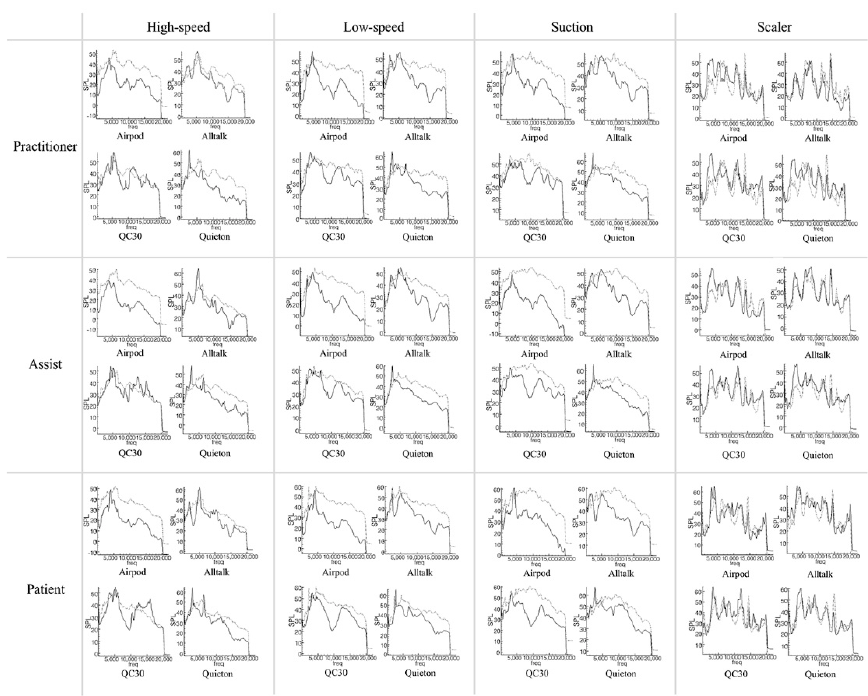
Figure 5. Comparison of sound pressure level during tooth preparation. Dash − dot graph represents control condition (dental noise) and solid graph represents experimental condition (active noise control devices).